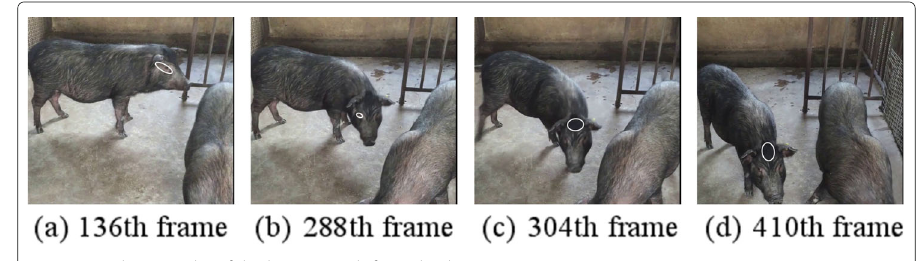
Fig. 2 Tracking results of the basic Camshift